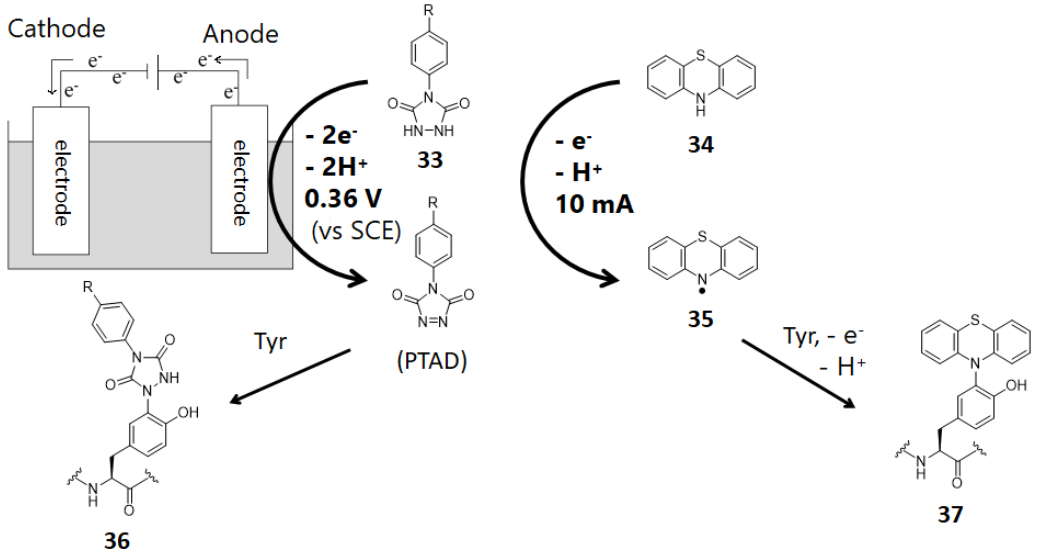
Figure 11. Electrochemical tyrosine labeling. SCE: saturated calomel electrode.